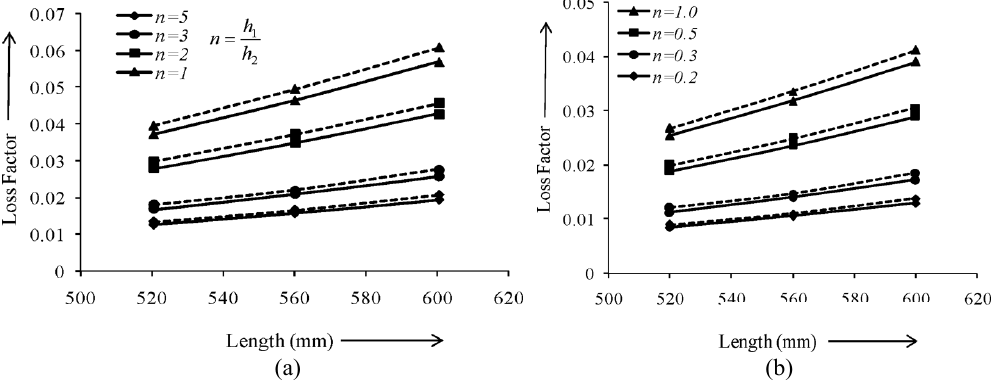
Fig. 13. (a) Variation of loss factor with length for jointed and welded cantilever beams of dimensions = 40.2 × 6 mm 2 and amplitude = 0.1 mm; (b) Variation of loss factor with length for jointed and welded cantilever beams of dimensions = 40.2 × 6 mm 2 and amplitude = 0.2 mm. Damping capacity of the layered and welded structures increases with the increase in length as shown in Fig.